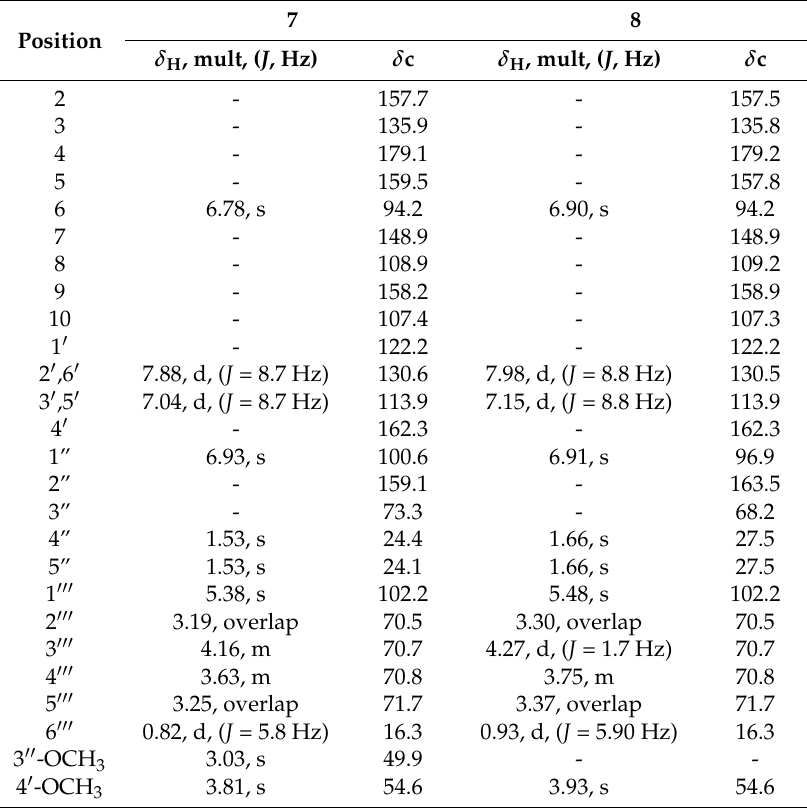
Table 1. 1 H-NMR and 13 C-NMR data of compounds 7 and 8 (500 MHz, MeOD).